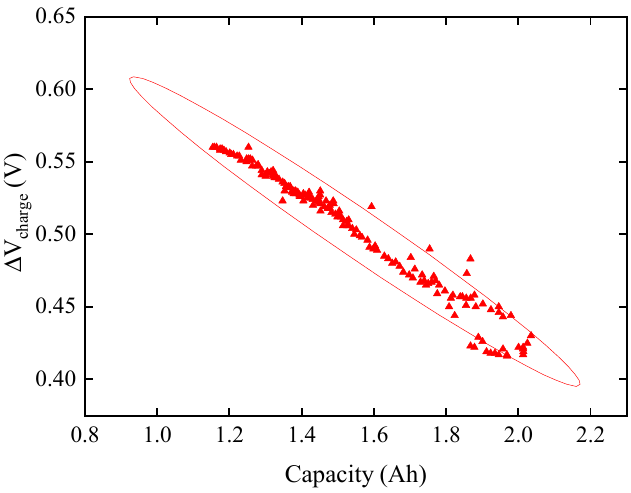
Figure 9. Scatter figure of Δ V charge .